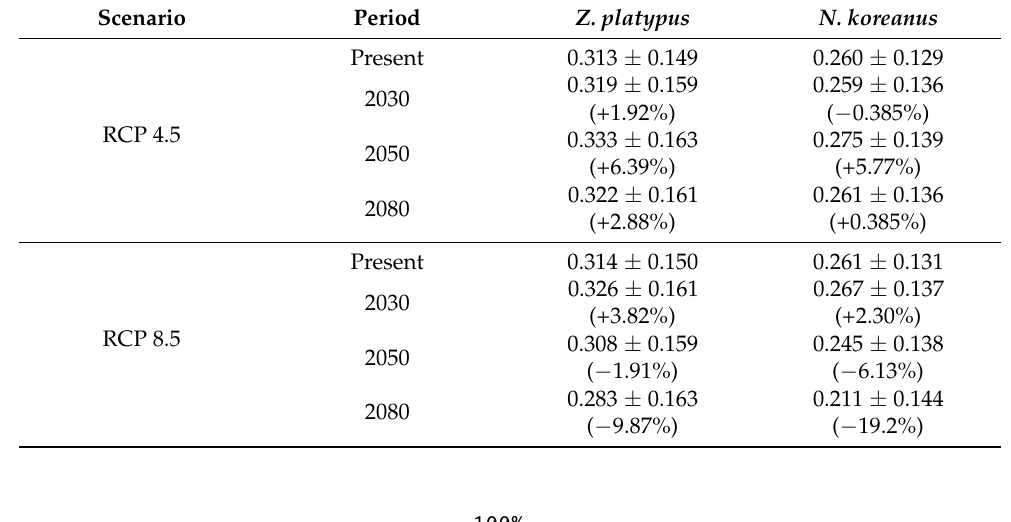
Table 1. Average and standard deviation (total 115 sites) of ecological habitat suitability (EHS) for Z. platypus and N. koreanus in South Korea at present (2008–2015), 2030 (2026–2035), 2050 (2046–2055), and 2080 (2076–2085). Numbers in the parenthesis indicate percent (%) change compared to present.